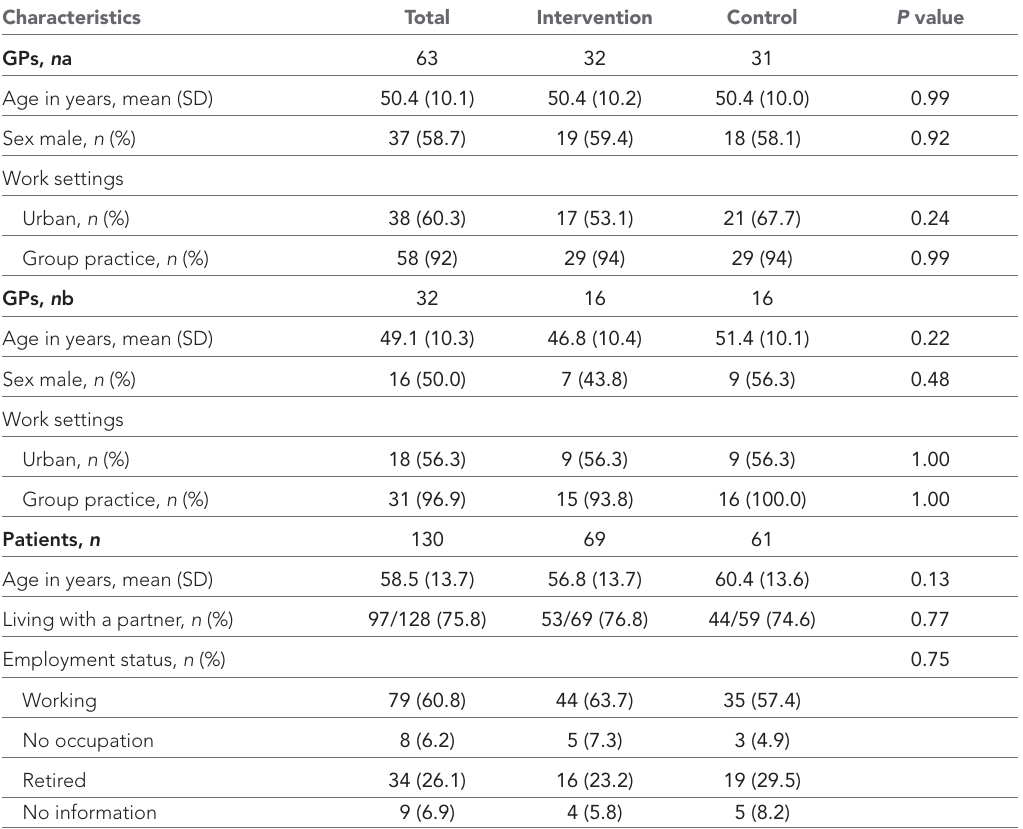
Table 1 Characteristics of the GPs and patients involved in the study Characteristics Total